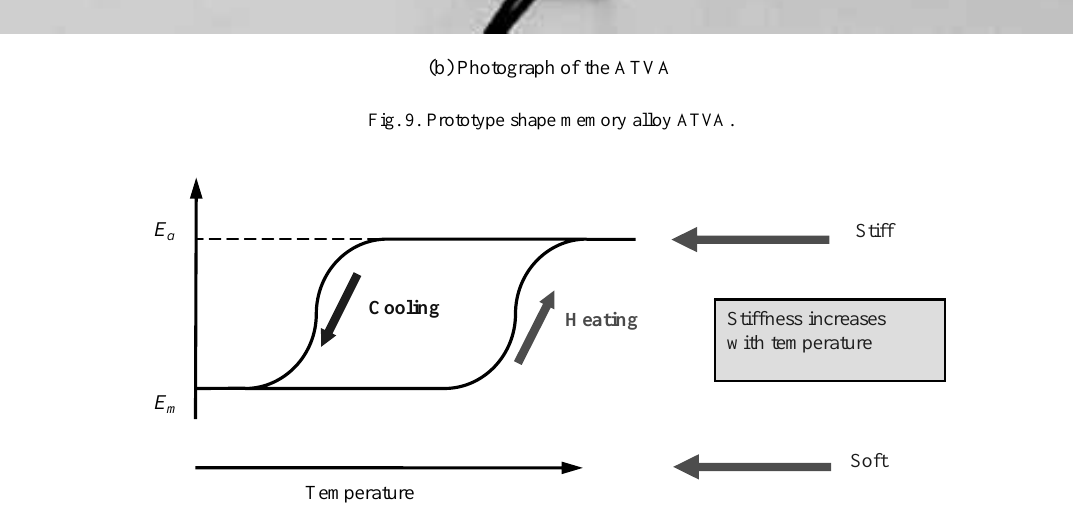
Fig. 10. Young’s modulus of NiTinol SMA wire as a function of temperature. E a and E m denote the Young’s modulus of the wire in its austenitic and martensitic states respectively. For the wire used in the prototype depicted in Fig. 9, the Young’s modulus changes from 40 to 59